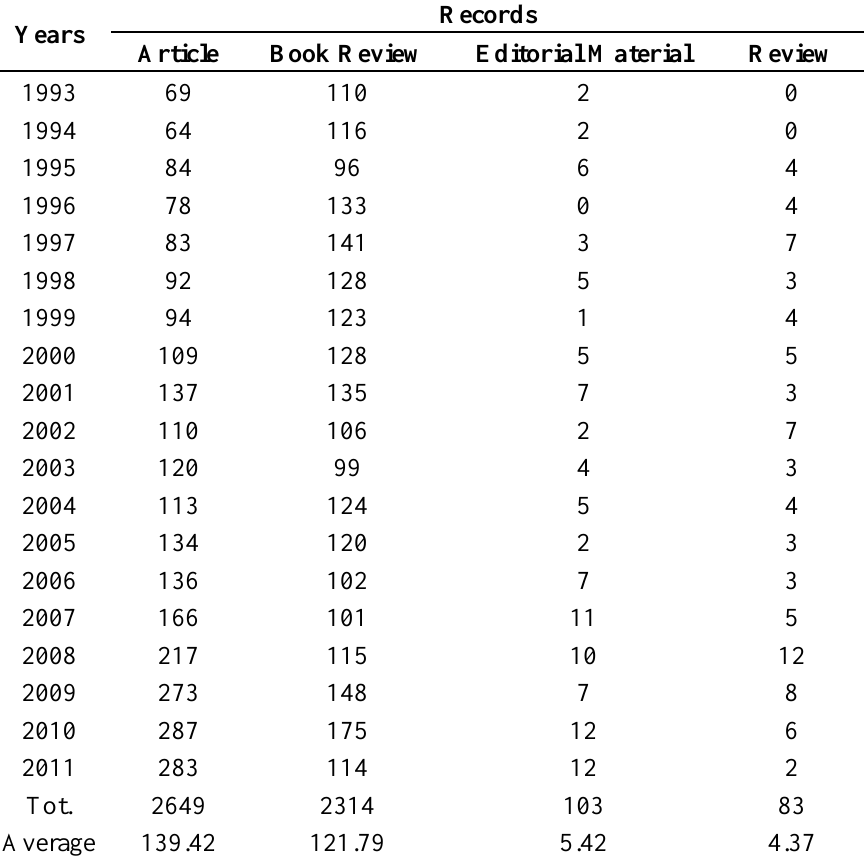
Table 5. Year-wise cumulative scholarly communications as Article, Book Review, Editorial Material, and Review on Buddhism and Buddhist studies collected between 1993 and